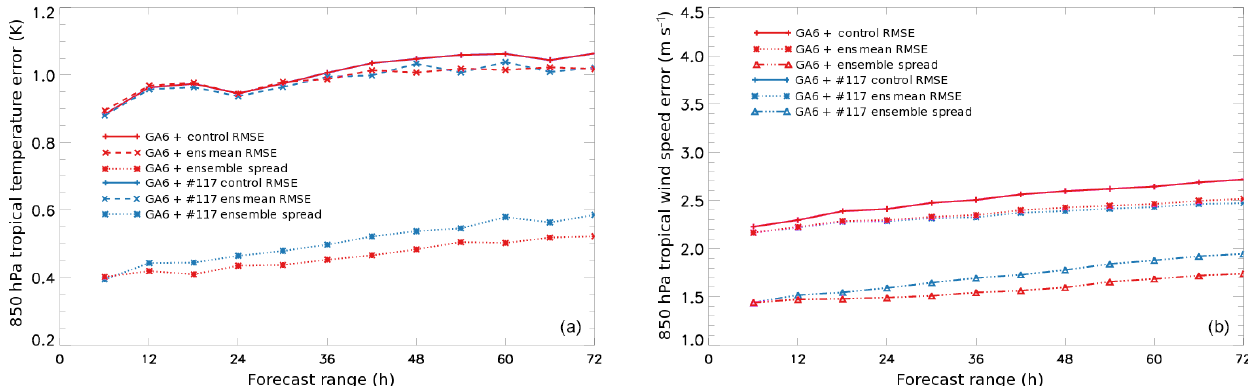
Figure 10. Ensemble error and skill for tropical temperature (a) and wind speed (b) versus radiosonde observations at 850hPa in an N216 ensemble with the operational MOGREPS-G and GA7 stochastic physics package.